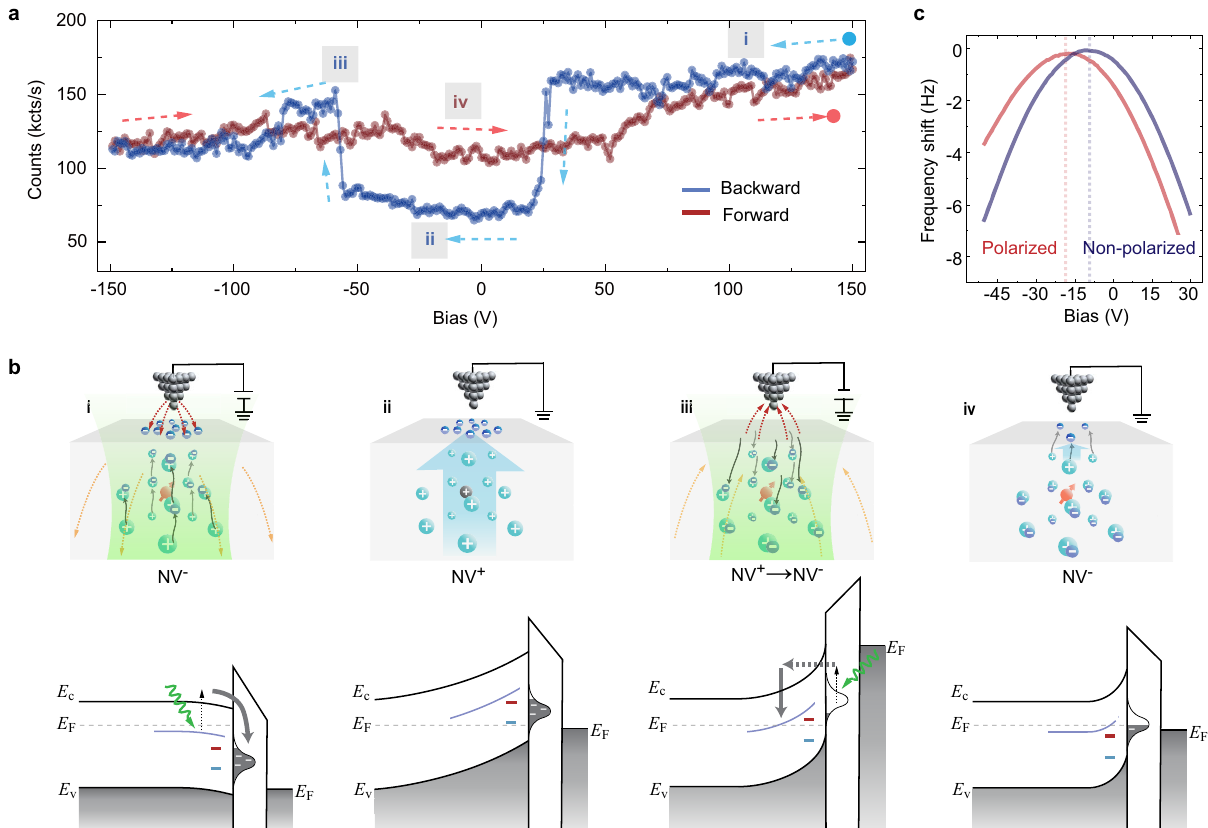
Fig. 4 Schematic model of the charge state control. a Fluorescence-bias curves over the full-bias range. The dashed arrows denote the direction of bias ramp. b Cartoon graphs (upper panels) and energy band diagrams (lower panels) showing the concerted effect of photon ionization and tip electric fi eld. Upper panels: red and black balls indicate NV _ and NV + states, respectively. Dashed arrows denote the local electric fi eld. Lower panels: the purple curve denotes the donor ’ s charge transition level, while blue and red short lines denote NV + / NV 0 and NV 0 /NV − transition levels, respectively. The waved green arrow denotes exciting photons. E F , E C , and E V denote the Fermi level, conduction, and valence band edges of diamond, respectively. (i) Under a large positive bias, lots of photon-ionized electrons (dark blue balls) from the donors (cyan balls) are driven upward and trapped by the surface defects. (ii) A strong built-in electric fi eld (light blue arrow) remains when the tip is grounded, leading to the upward band bending and the NV + state. (iii) The surface- trapped electrons are photoexcited and tunnel to the conduction band under negative bias, thence recombined with the donors, depolarizing the surface and leading to the NV ˉ state again. (iv) When the bias is grounded again, only shallow donors are depleted due to the electron transfer to surface defects and a small built-in electric fi eld is formed, thus the NV − state remains. c LCPD measurements con fi rmed the negatively charged surface after polarization. Setpoint: 4 f AFM = + 20